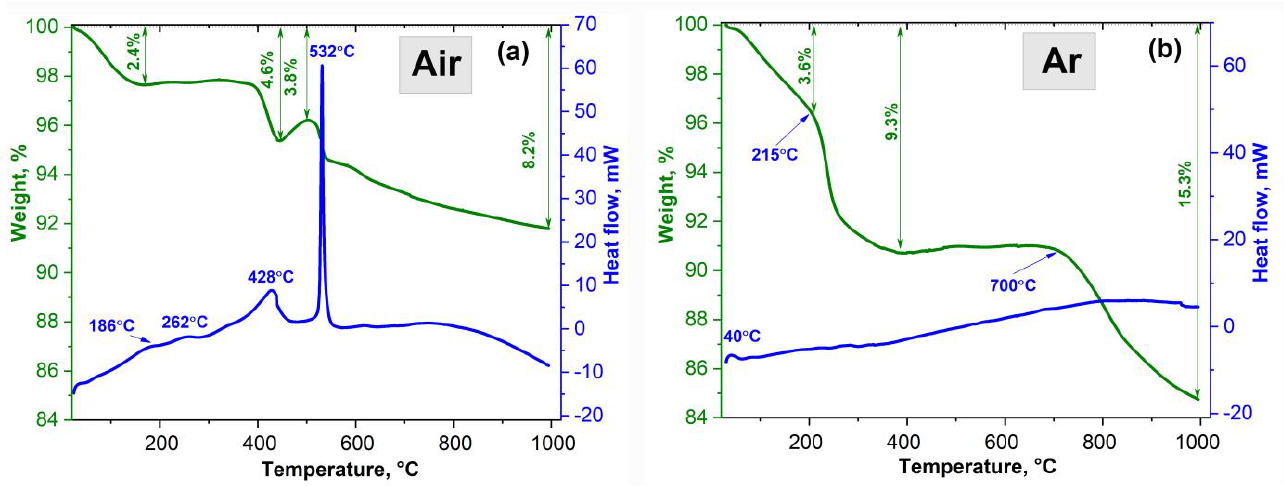
Figure 1. The X-ray powder patterns of the original Ti 2 AlC MAX-phase and the obtained Ti 2 CT x MXene ( a ) and the Ti 2 CT x MXene microstructure particles according to TEM ( b – d ) and SEM ( e – g ).